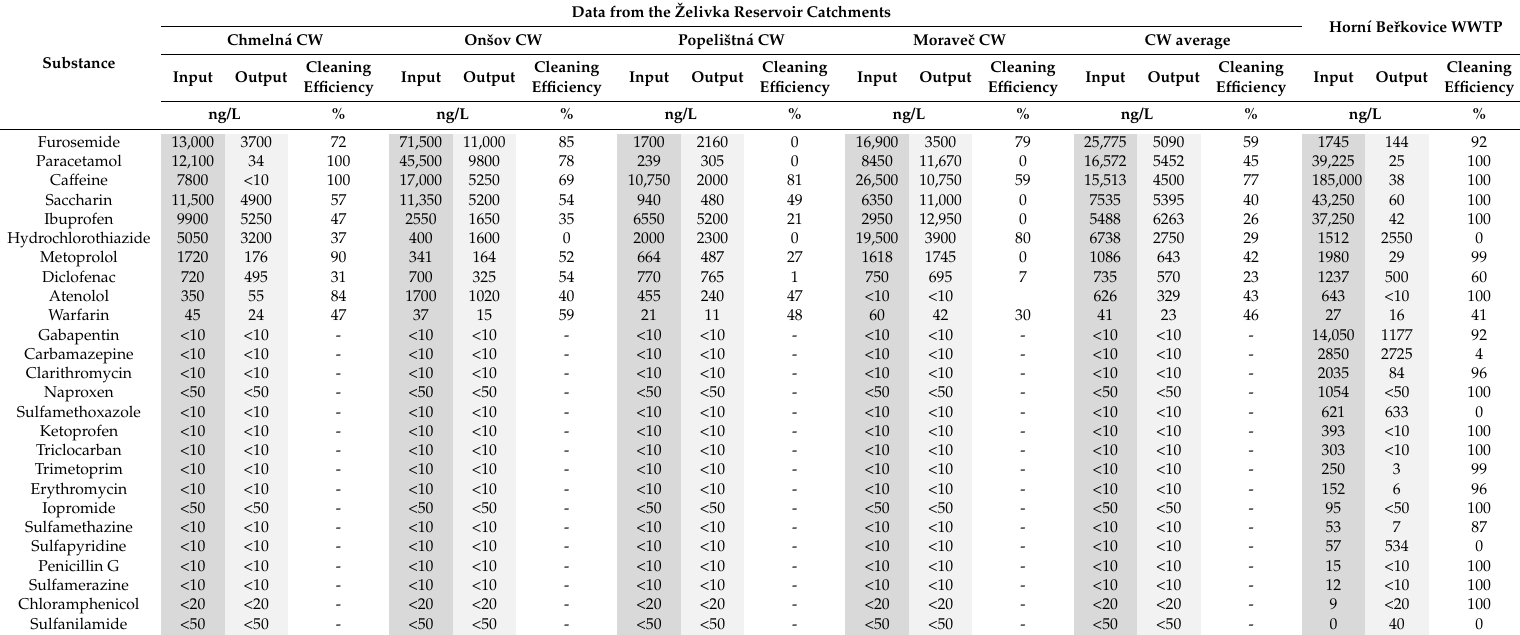
Table 3. Average concentrations of individual pharmaceuticals at the inflow to and outflow from monitored constructed wetlands (CW) and wastewater treatment plants (WWTP) in